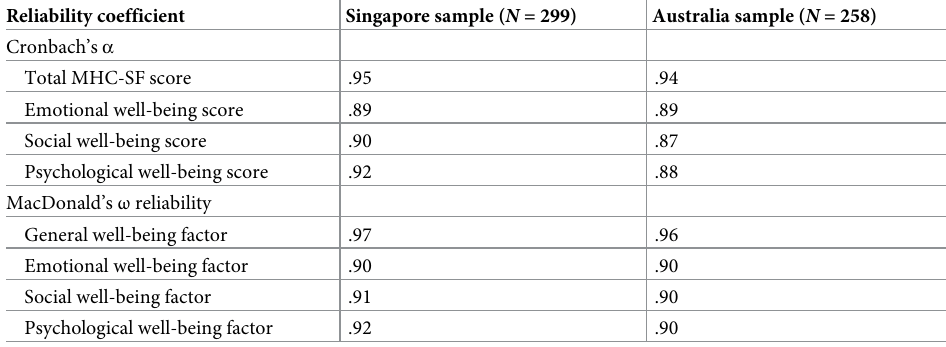
Table 7. Cronbach’s α and MacDonald’s ω reliability coefficients of